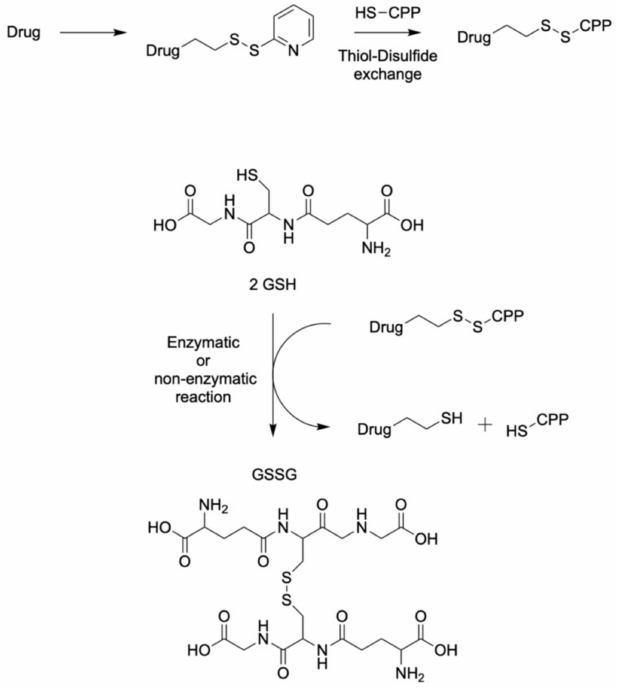
Scheme 6. Schematic representation of disulfide linker introduction and cleavage, according to reference